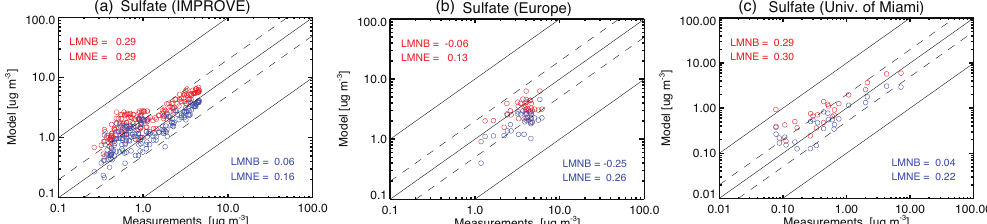
Figure 8. Scatter plot of annually averaged surface sulfate mass concentrations (µgm − 3 ) in the model (red for ModelE2-TOMAS and blue for ModelE2-OMA) and observation from (a) the IMPROVE network, (b) the European sites from Putaud et al. (2010), and (c) the University of Miami. Note that the sulfate in the model is simply converted to ammonium sulfate at the IMPROVE